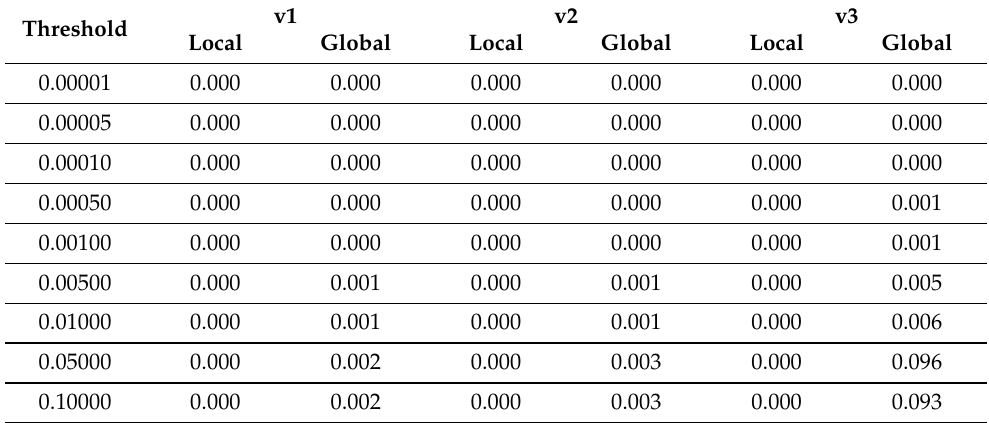
Table 15. diabetes—local and global approximation propagation error analysis. cho_0 cho_2 Threshold Local Global Local Global Local